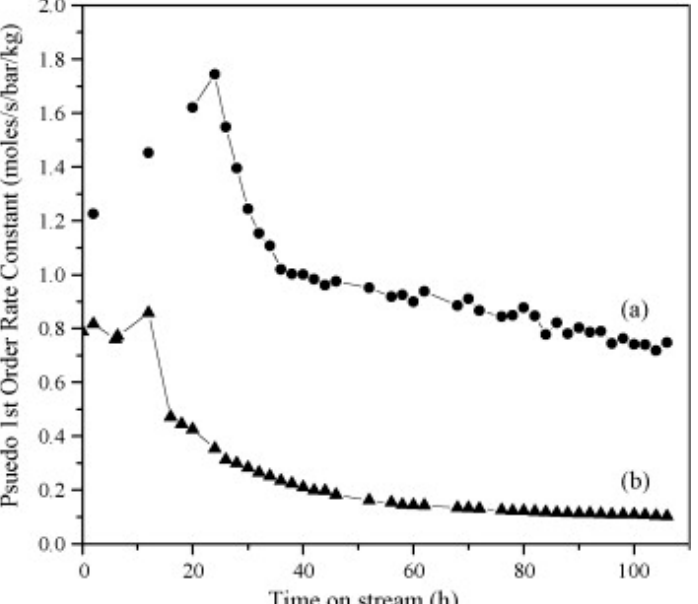
Figure 3. Comparison of the activity in methanol conversion of ( a ) NiAl-LDH with potassium and ( b ) commercial catalyst at 390 °C and steam/carbon molar feed ratio of 1.2. Both catalysts were pre- activated in situ at 240 °C for 6 h on a reactive stream before reaction. Reprinted with permission from Ref. [65]. Copyright 2022 Elsevier.